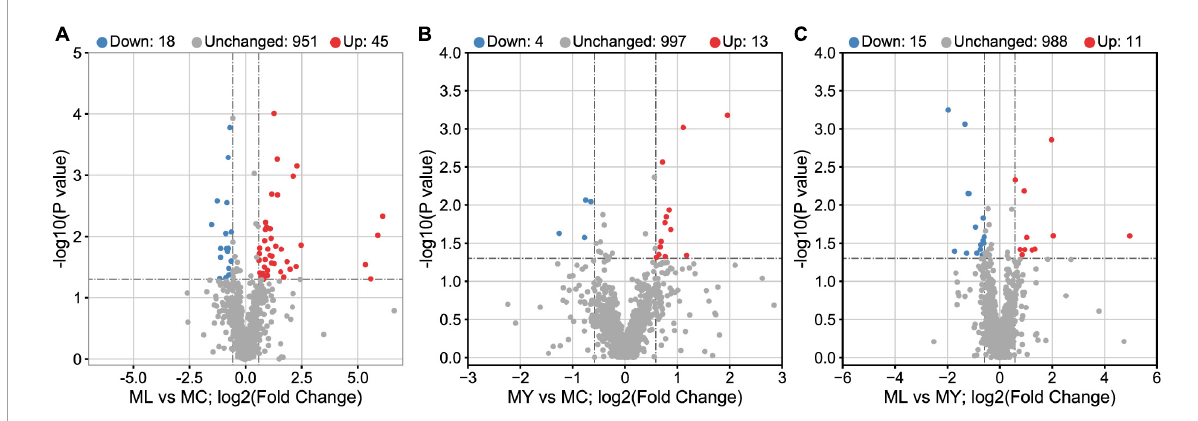
FIGURE8 Volcano plots of rumen known metabolites in (A) ML vs. MC, (B) MY vs. MC, and (C) ML vs. MY. The known metabolites in positive ion mode and negative ion mode were combined. Rumen metabolites with FC (fold change) > 1.5, VIP (variable importance in the projection) > 1.5, and P -value < 0.05 were considered significant. Each point in the volcano plot represents a metabolite. Blue dots represent down-regulated differential metabolites, red dots represent up-regulated differential metabolites, and gray dots represent detected but insignificant